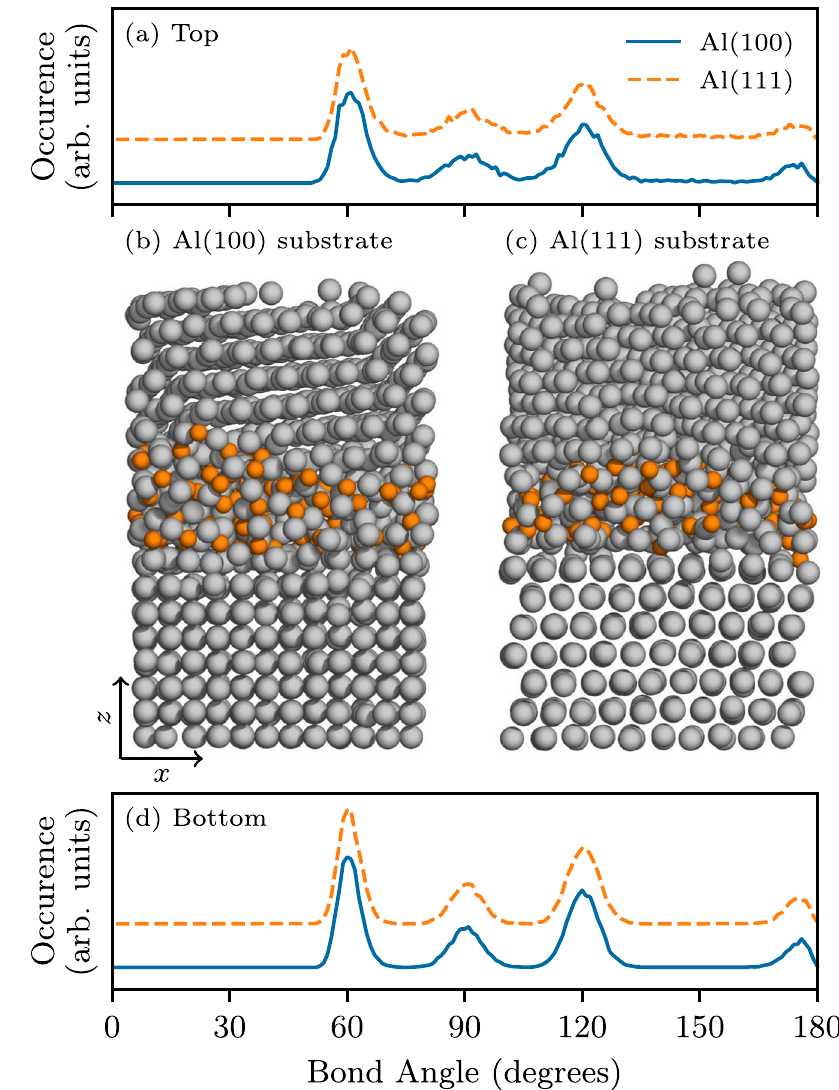
Fig. 13 Bond angle comparison between the constructed and deposited aluminium regions. a Bond angles in the top aluminium contact grown by deposition. b The junction structure as grown on Al(100). c The junction structure as grown on Al(111). d Bond angles in the bottom 24 × 24 Å 2 substrates. This calculation was performed with the ReaxFF